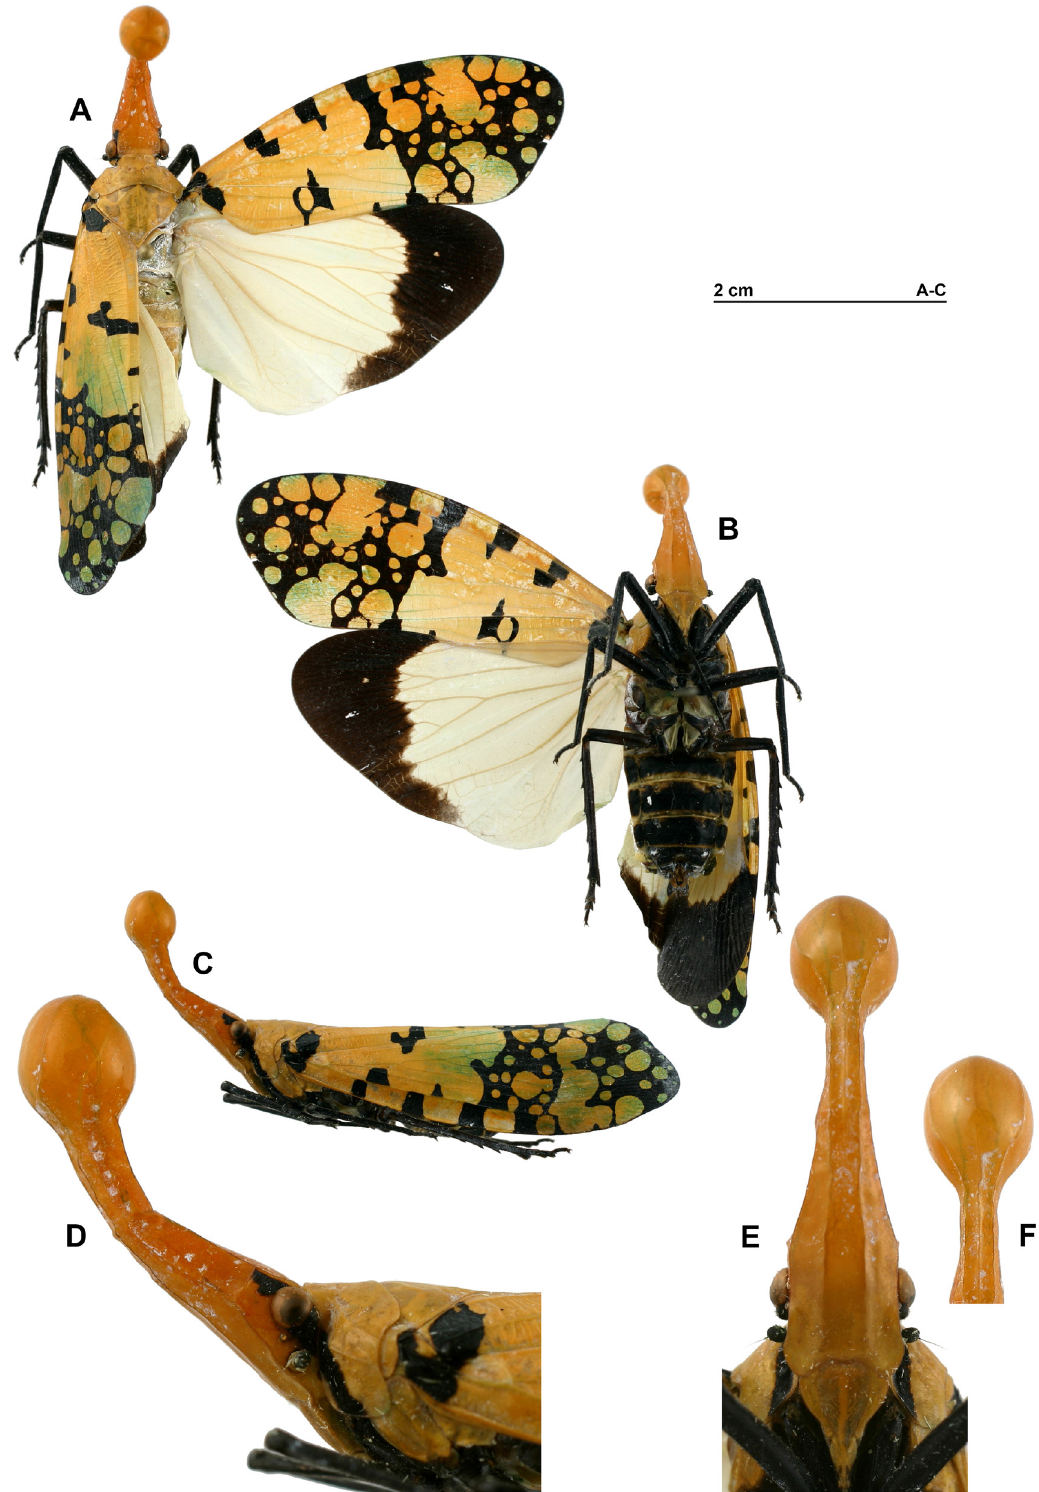
Fig. 9. Pyrops atroalbus (Distant, 1918), ♀, Vietnam, Quang Tri Prov., Da Krong Nature Reserve, 10 Jul. 2011 (VNMN). A . Habitus, dorsal view. B . Habitus, ventral view. C . Habitus, lateral view. D . Head and thorax, lateral view. E . Head, perpendicular view of frons. F . Apex of cephalic process, anteroventral view. D–F = not to